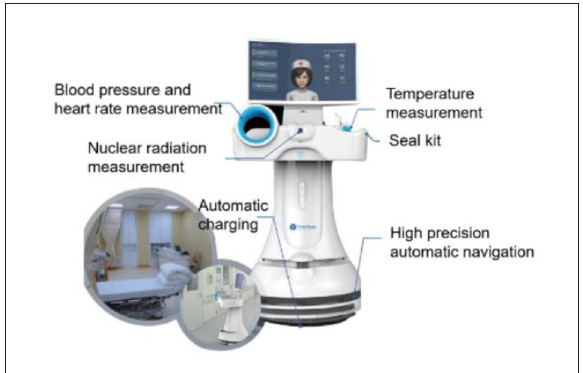
FIGURE1 Nuclear medicine medical isolation ward mobile robot.